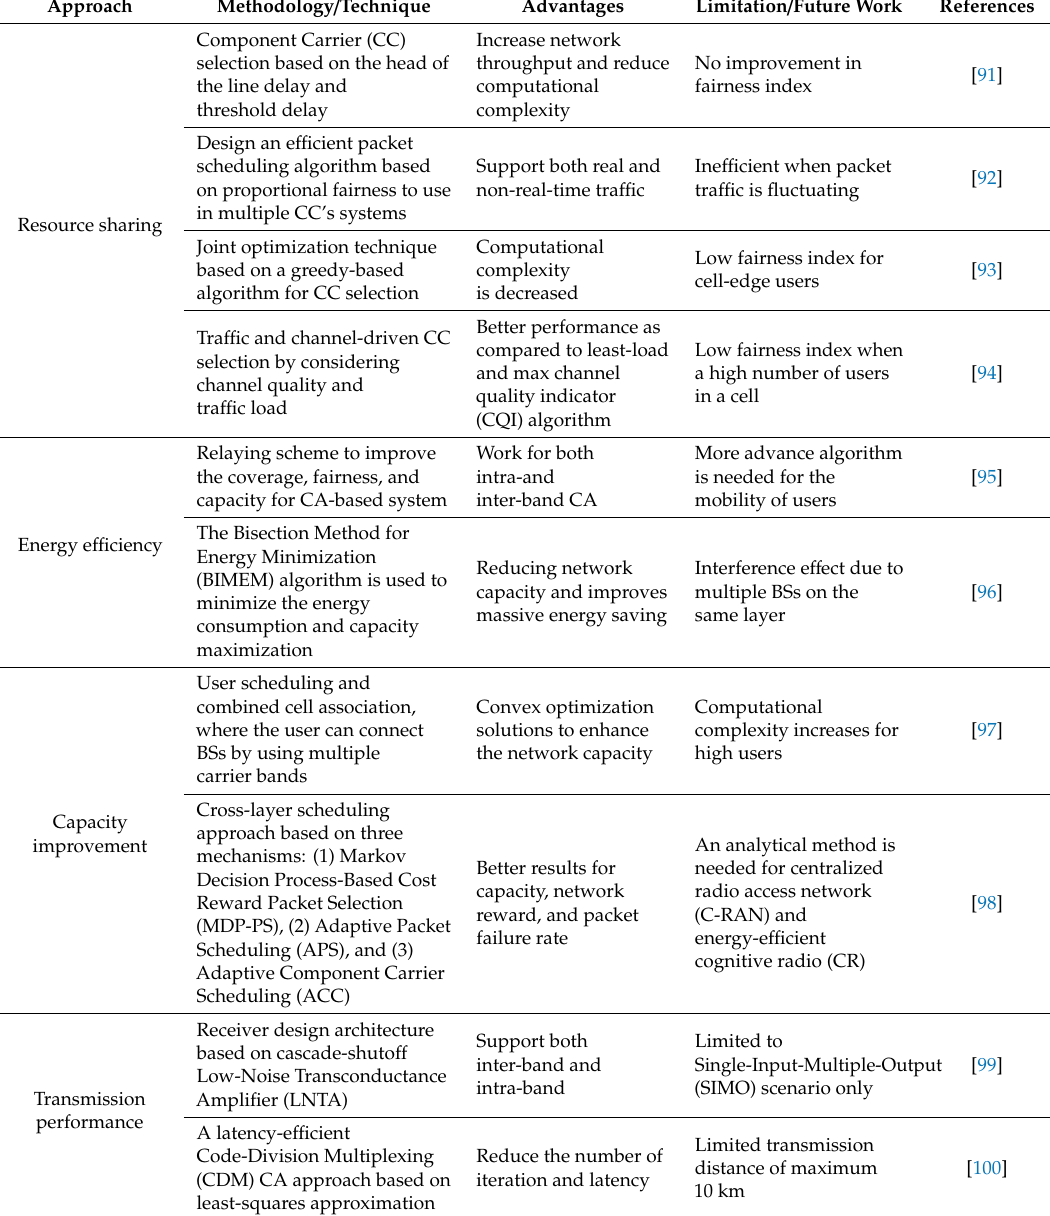
Table 1. Summary of the related work for Carrier Aggregation